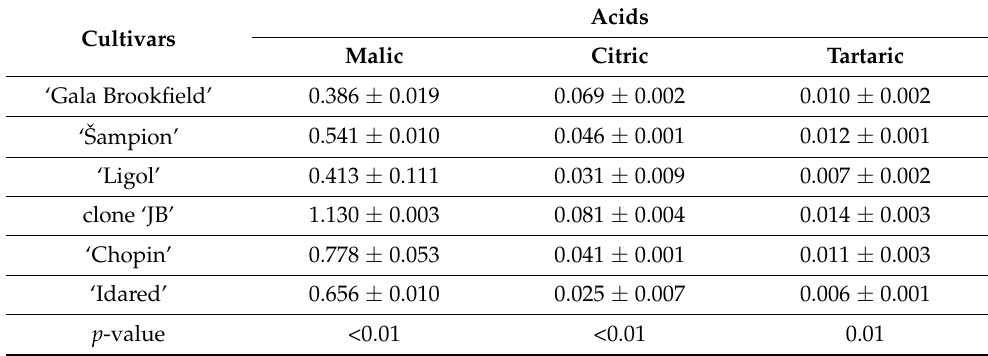
Table 6. The values of acid content (g · 100 g − 1 FW) for apples depending on testing cultivars. Acids Cultivars Malic Citric Tartaric ‘Gala Brookfield’